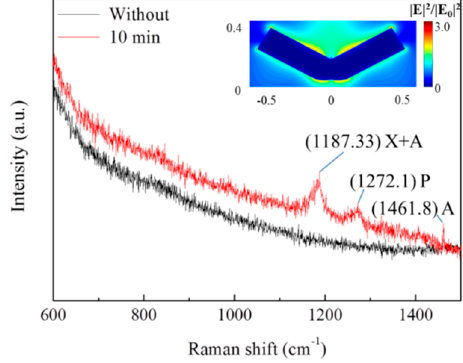
Figure 6. SERS signals of Ag nanowires before and after 10 min ultrasonic treatment.